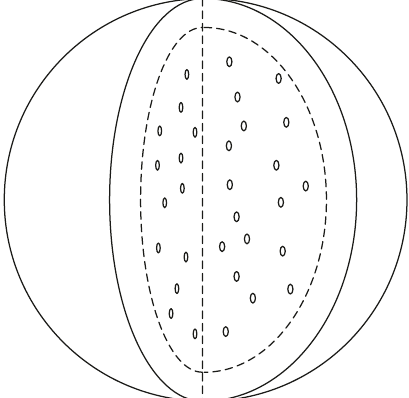
Figure 1: Sketch of a spherical fuel element used in HTGR stuffed with TRISO fuel particles.